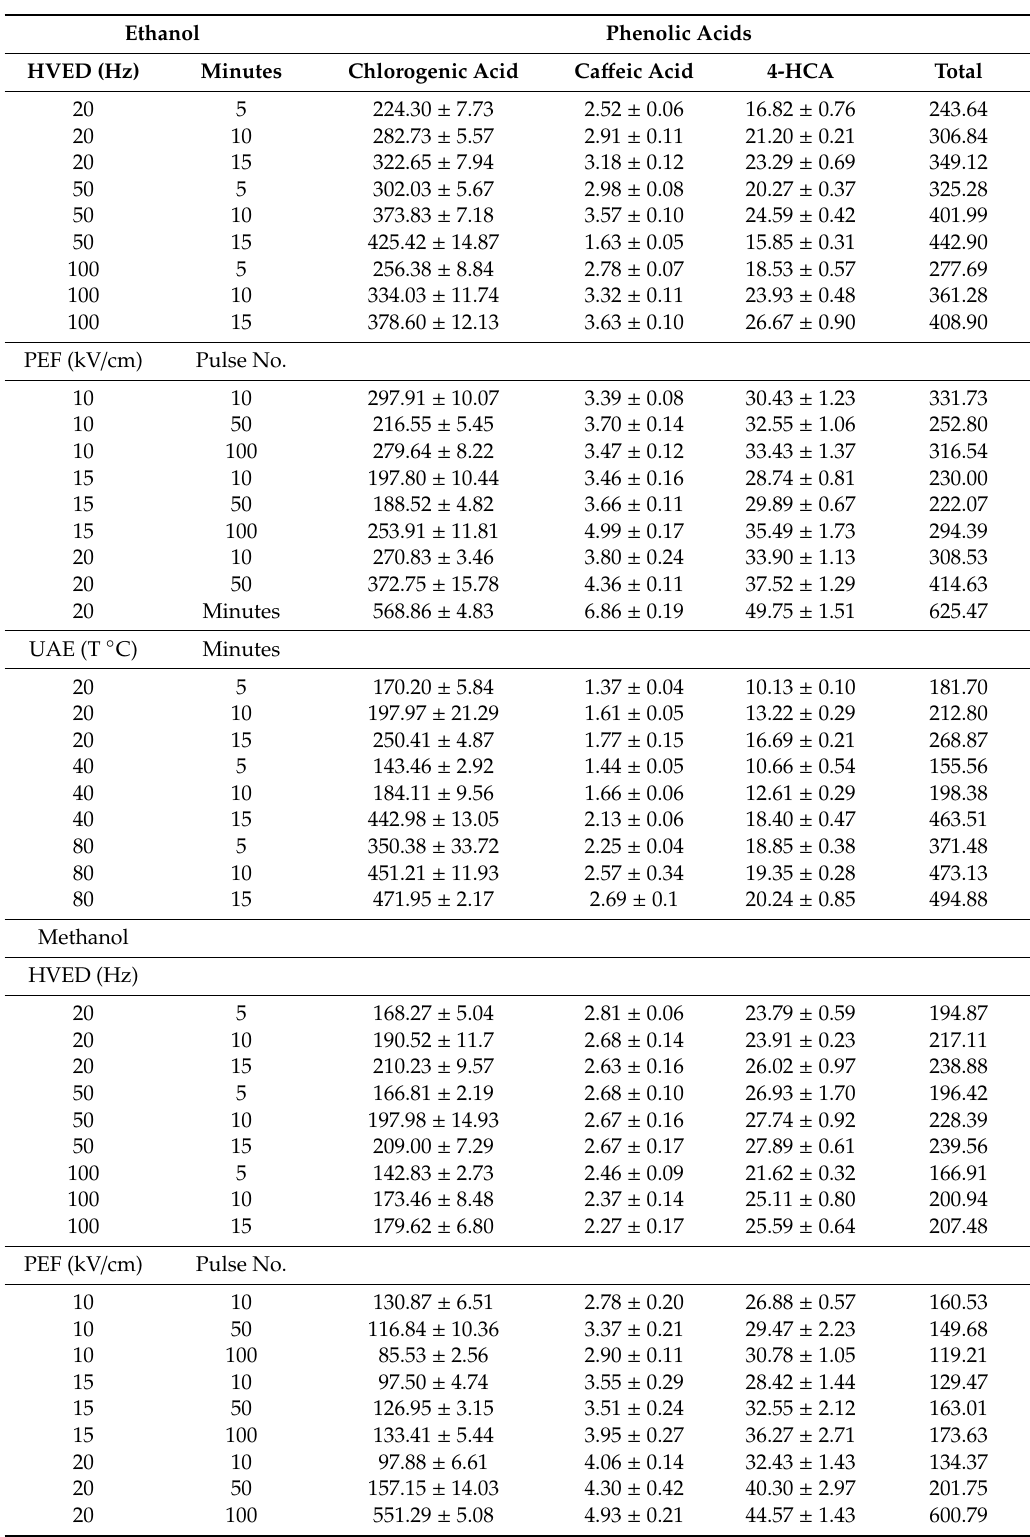
Table 3. Phenolic acids content ( µ g / g of dw) in the analysed extracts obtained after high voltage electrical discharges (HVED), pulsed electric field (PEF), and ultrasound-assisted extraction (UAE) of blueberry